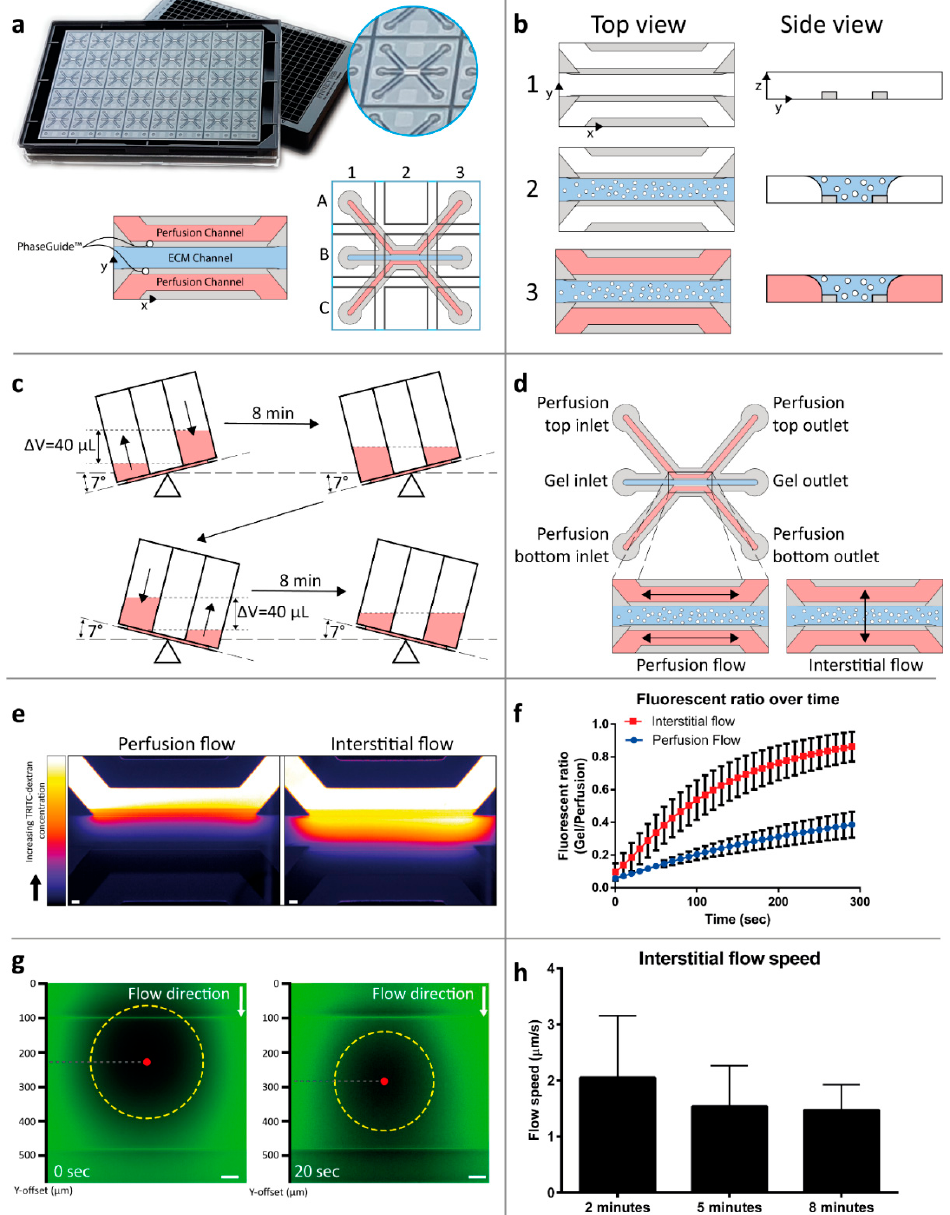
Figure 1. Interstitial flow-on-a-chip characterization. ( a ) The microfluidic microtiter plate ‘OrganoPlate’ was used for a 3D cell culture, based on a 384 well plate interface with 40 microfluidic chips integrated in the bottom. A gel channel (blue) holds the extracellular matrix (ECM) in place through the PhaseGuide’s pressure barrier function. ( b ) Cells can be introduced in the middle lane (gel channel) to create a 3D